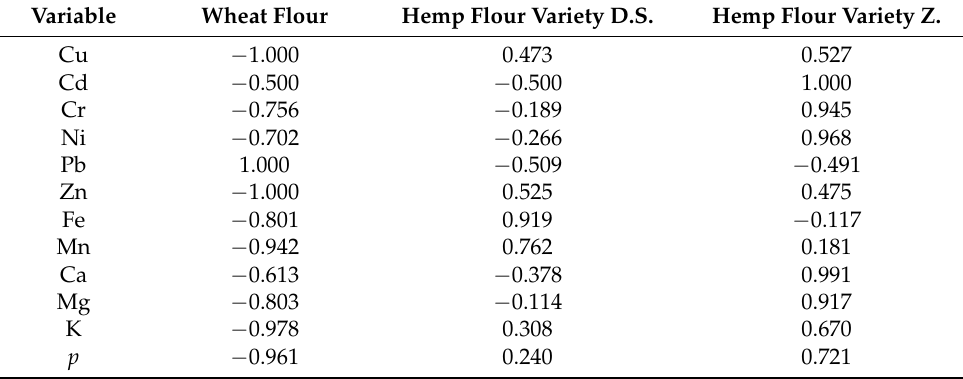
Table 4. Pearson correlation for micro and macroelements of flour sample.